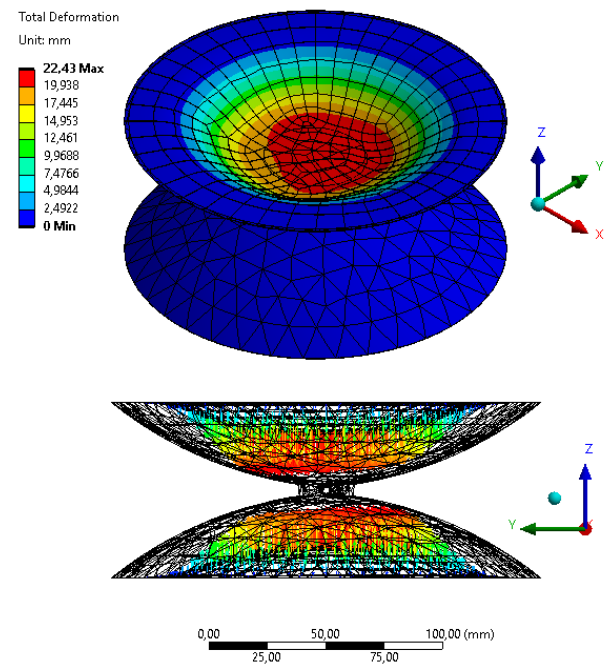
Figure 11. A grid view in the FEM model and distribution of force vectors.